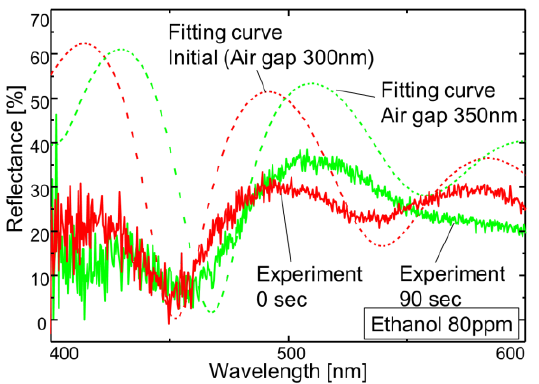
Figure 9. Reflectance spectrum of the Fabry–Perot interferometer with a change in the air gap. The optical multilayer films are designed to use 350-nm-thick parylene-C and 400-nm-thick silicon dioxide with air gaps of 300 nm and 350 nm.